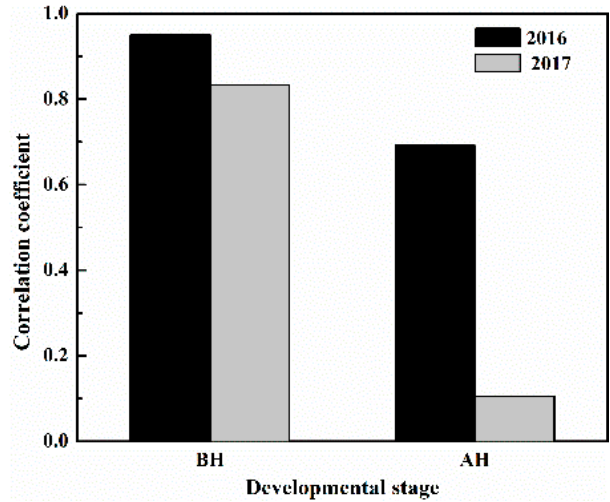
Figure 7. Correlation coefficient between growth rate (GR) at different developmental stages and rice yield. BH: growth period before heading; AH: growth period after heading.